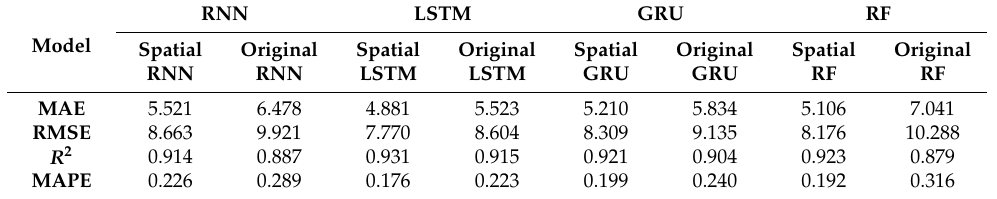
Table 3. Model performance of the proposed space diffuser and comparisons with other models. RNN LSTM GRU RF Model Spatial Original Spatial Original Spatial RNN RNN LSTM LSTM